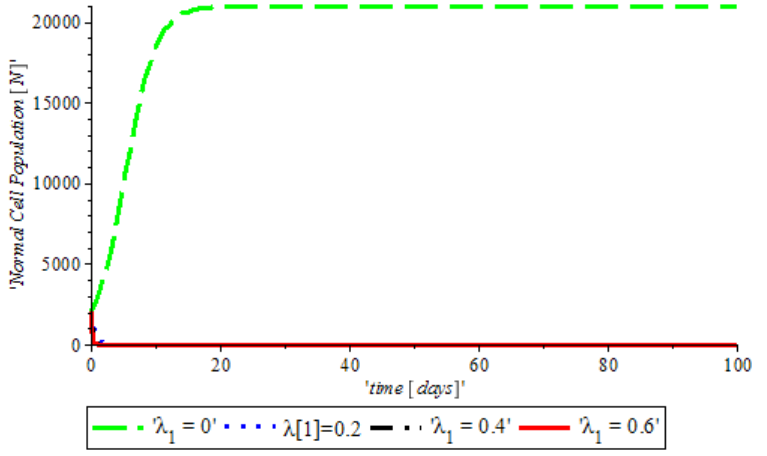
Figure 9. The variation of proportion of Normal cell population for different values of λ 1 with other parameters fixed.